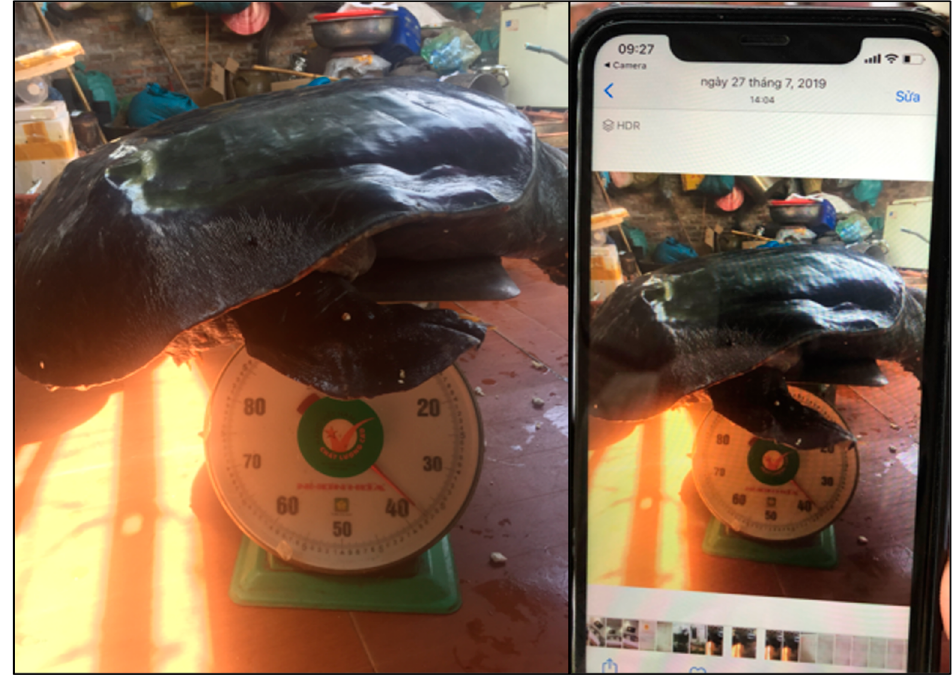
Figure 5. A 38-kg softshell turtle brought by a customer to a local restaurant on the 27 July 2019 in Bac Giang province.